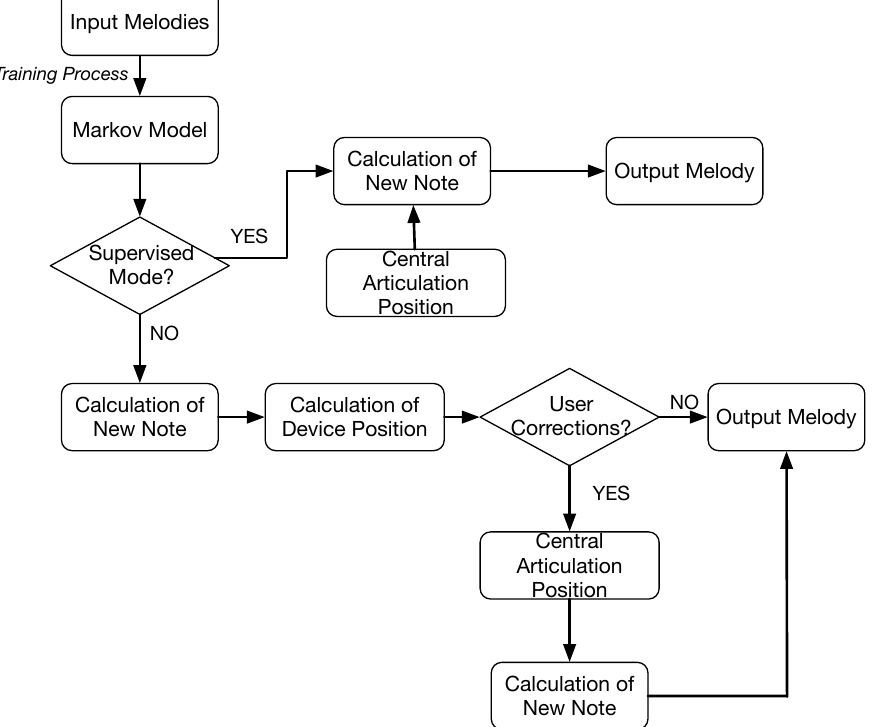
Figure 6. Schema with the adaptation process to generate a new